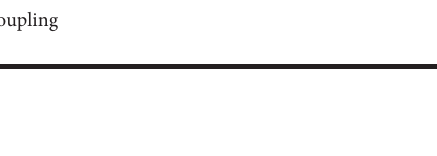
Figure 7: Angular misalignment of coupling of the inner rotor.